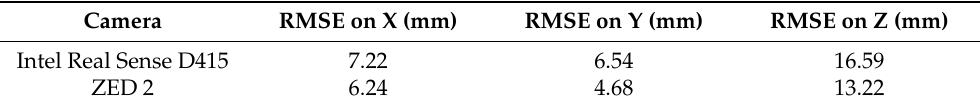
Table 4. Comparative characteristics of coordinate estimation (RMSE are measured in mm). Camera